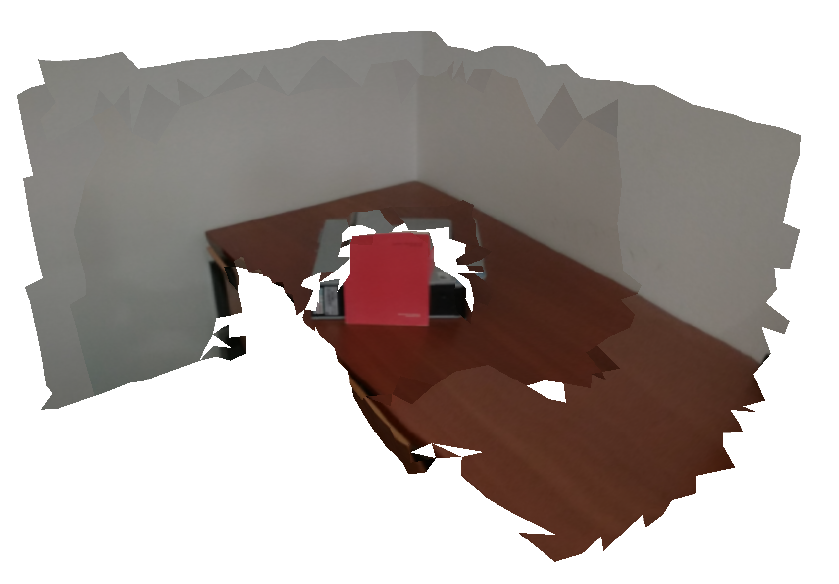
Figure 7. Textured mesh generated using the depth consistency algorithm. Notice that, in comparison with the standard winner-takes-all strategy displayed in Figure 2b, the red color (from the book) is not mapped on the